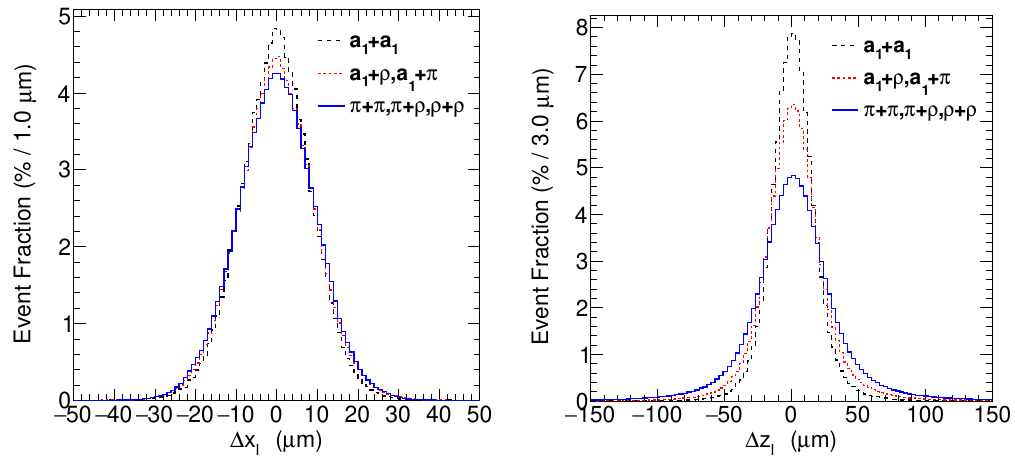
Figure 5 . The distributions of (cid:1) x I ( x (cid:12)t